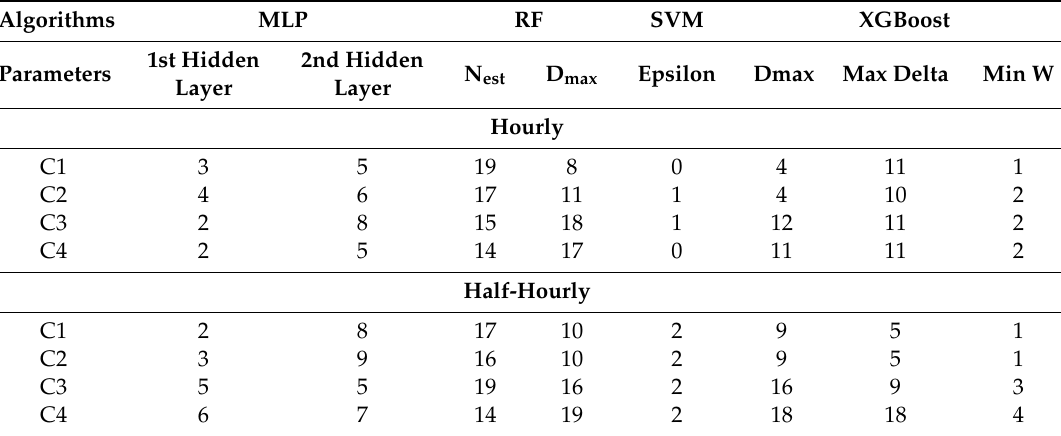
Table A2. Optimized model parameters of grassed (GA)